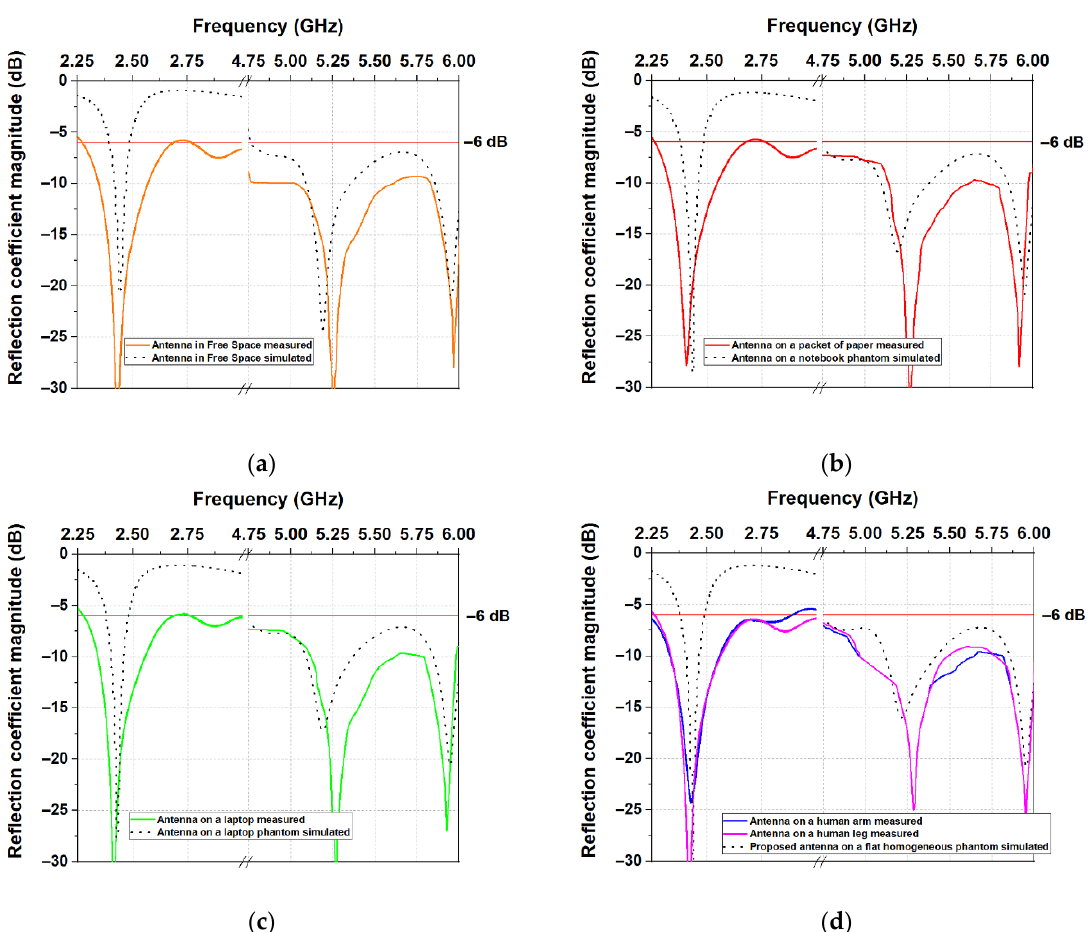
Figure 11. Measured and simulated reflection coefficient |S 11 |: ( a ) in free space; ( b ) on the copy- printer paper; ( c ) on the laptop; ( d ) on the human arm, leg, and flat phantom.